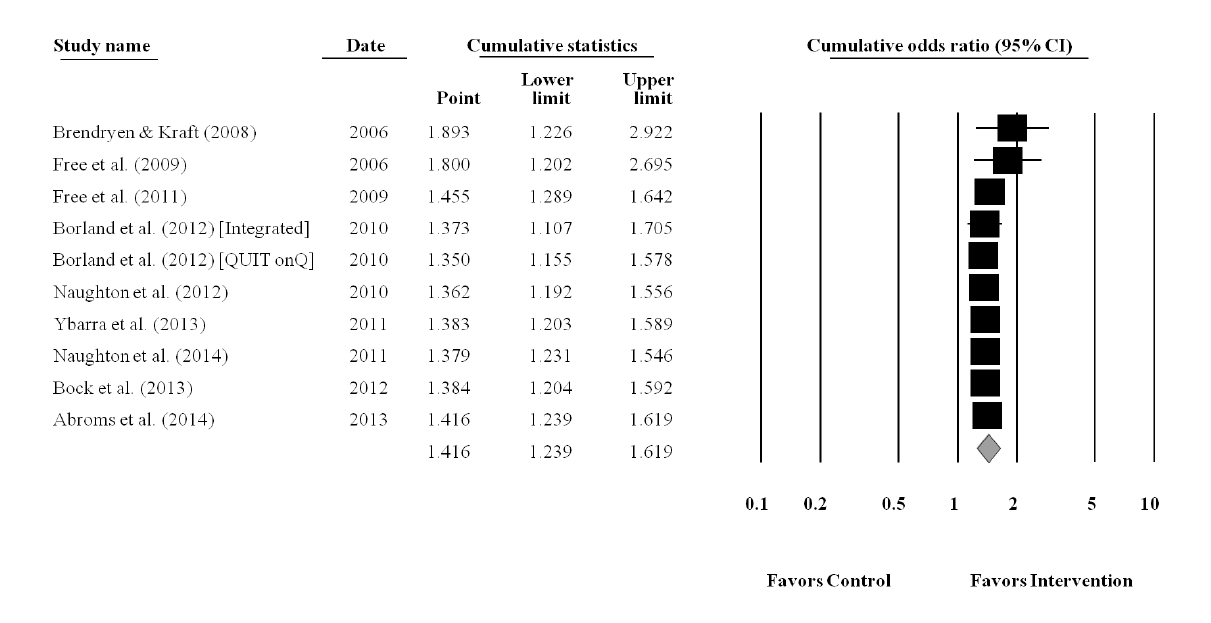
Figure 4. Cumulative plot of the overall weighted mean effect sizes and the corresponding 95% confidence intervals for smoking abstinence, based on final date of data collection and restricted to studies with moderate to high methodological quality